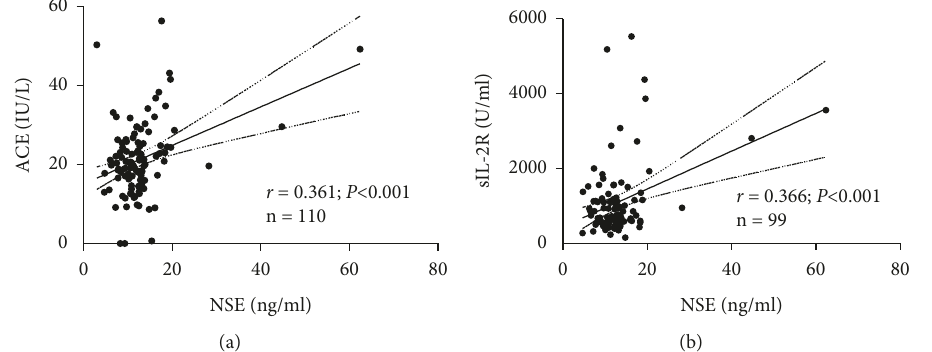
Figure 1: Significant correlations between (a) NSE and ACE and between (b) NSE and sIL-2R, as analyzed by the Pearson correlation coefficient. The best-fit line with its 95% confidence interval is